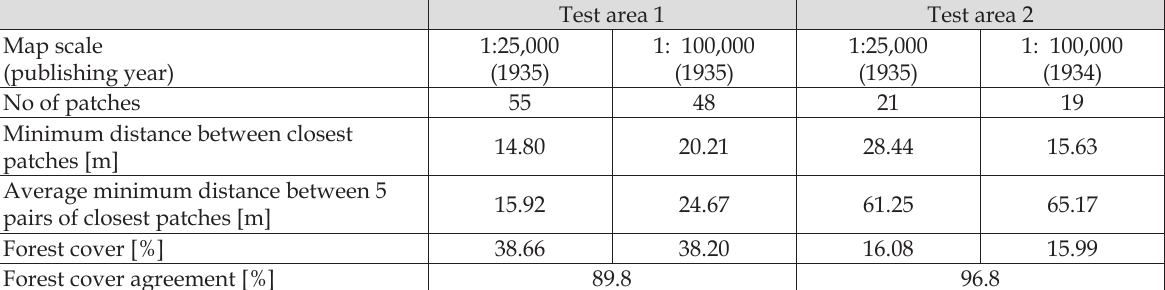
Table 1. Forest cover distribution and distance indicators on 1:100,000 and 1:25,000